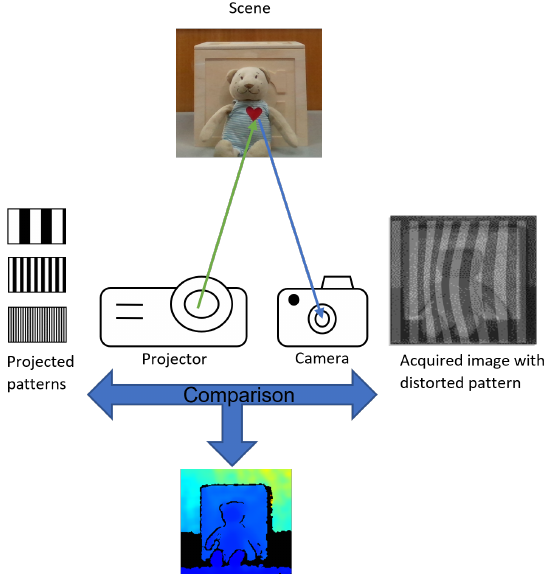
Figure 2. An illustration of a Structured Light sensor: the projector emits one or more patterns sequentially onto the scene. These patterns are warped by the scene, reflected back and captured by the camera. The scene depth is estimated by comparing the projected patterns and the distorted ones acquired by the